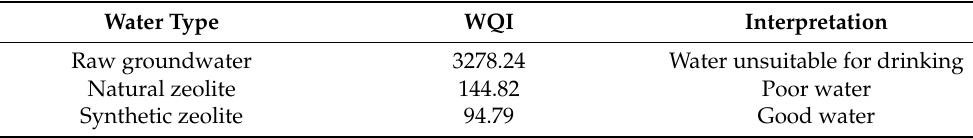
Table 11. Summary of the aggregated water quality